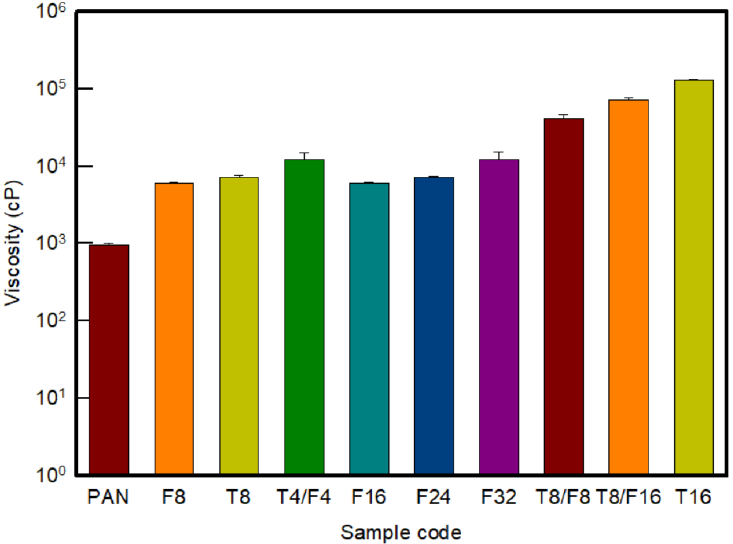
Figure 4. Viscosity of the PAN-based composite solution with various contents of carbon nano-materials.